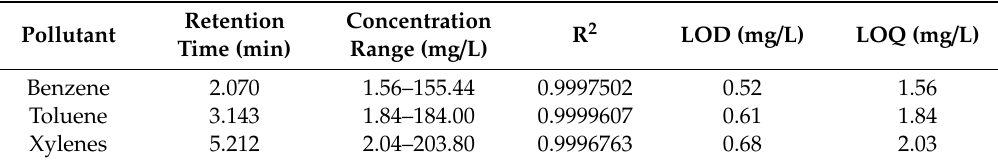
Table 2. Calibration curves analytical parameters.